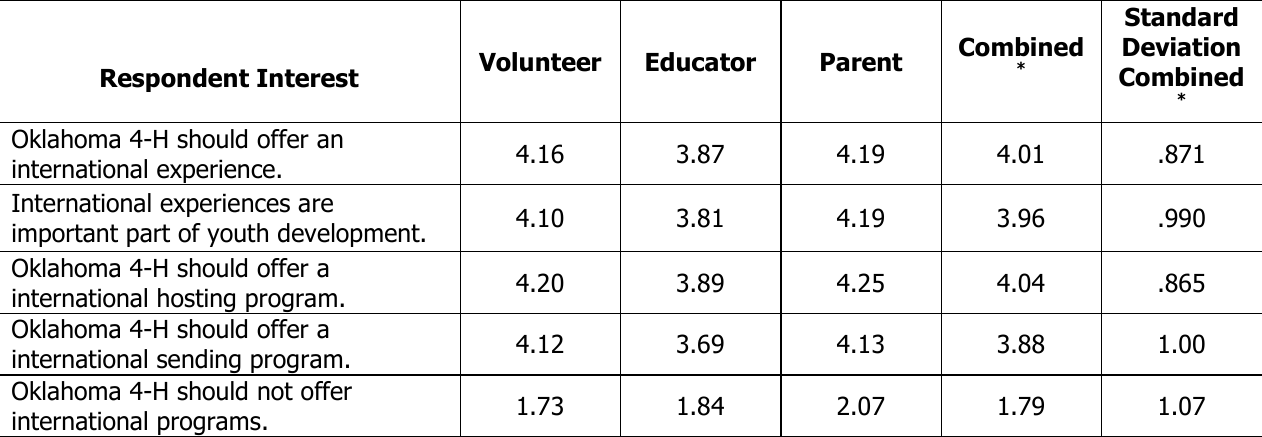
Respondent interest in international